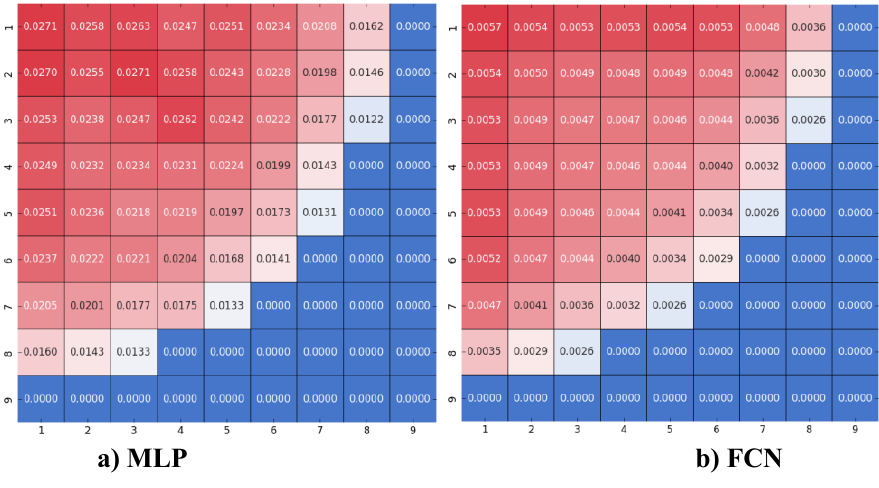
Figure 6. The MAE for each node in the core